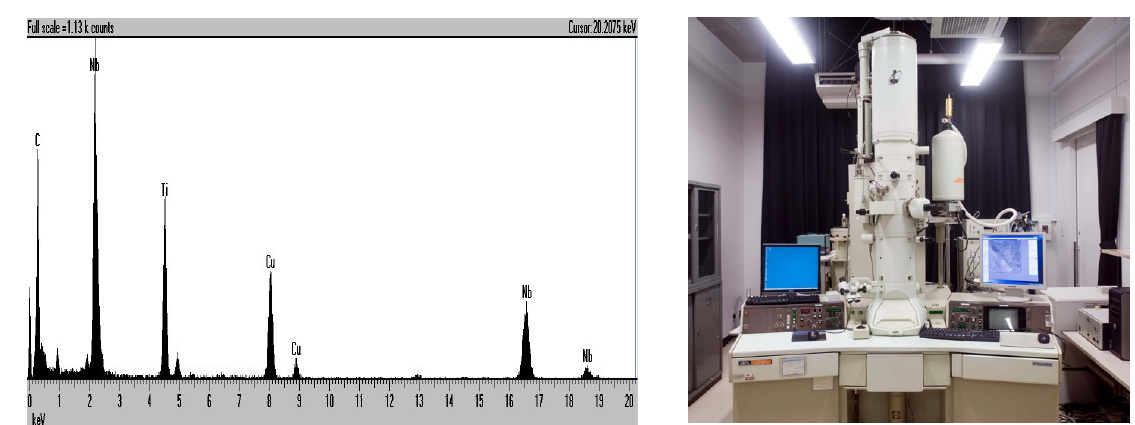
Fig. 7: TEM Micrographs for Sample A. EDS Peaks are shown as